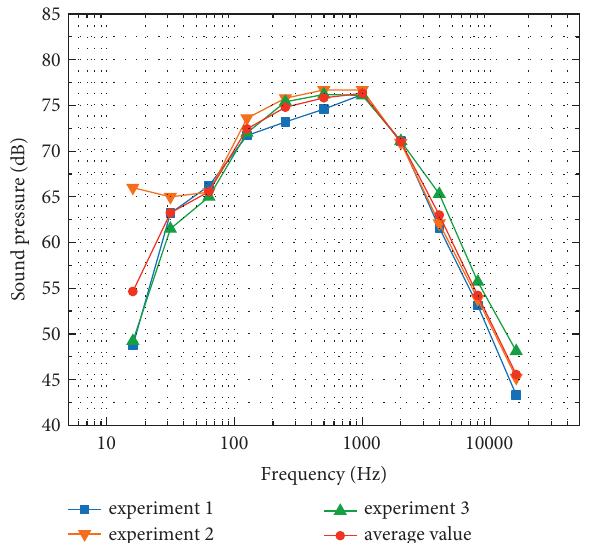
Figure 20: Sound pressure level by